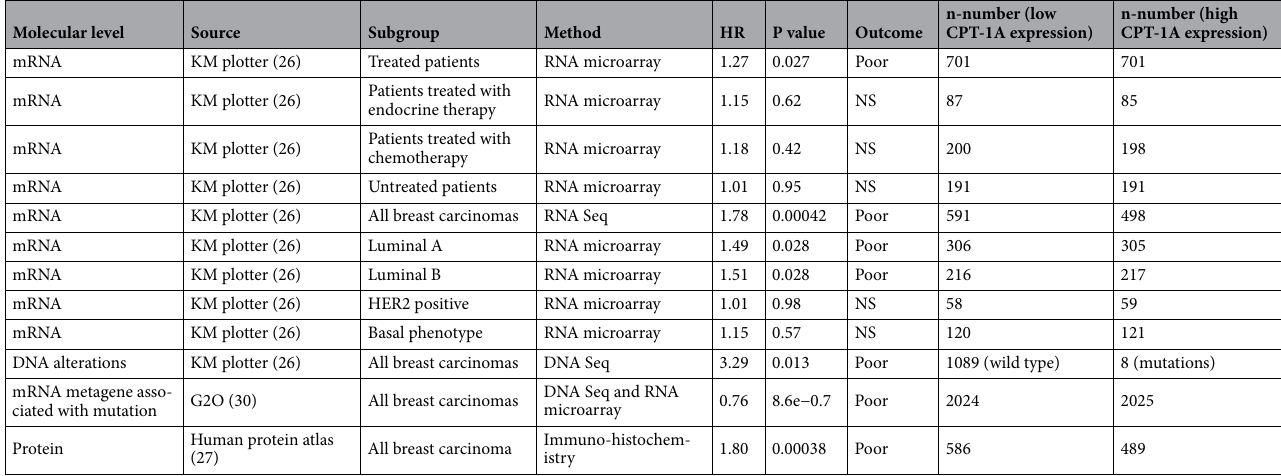
Table 1. CPT-1A expression and breast cancer. Summary table detailing hazard ratios (HR), p values and outcomes of overall survival data in breast carcinomas showing the predictive and prognostic effects of high CPT-1A expression at mRNA and protein level, and of CPT-1A mutations/alterations. The data has been obtained from the KM plotter, G2O and the Human Protein Atlas.